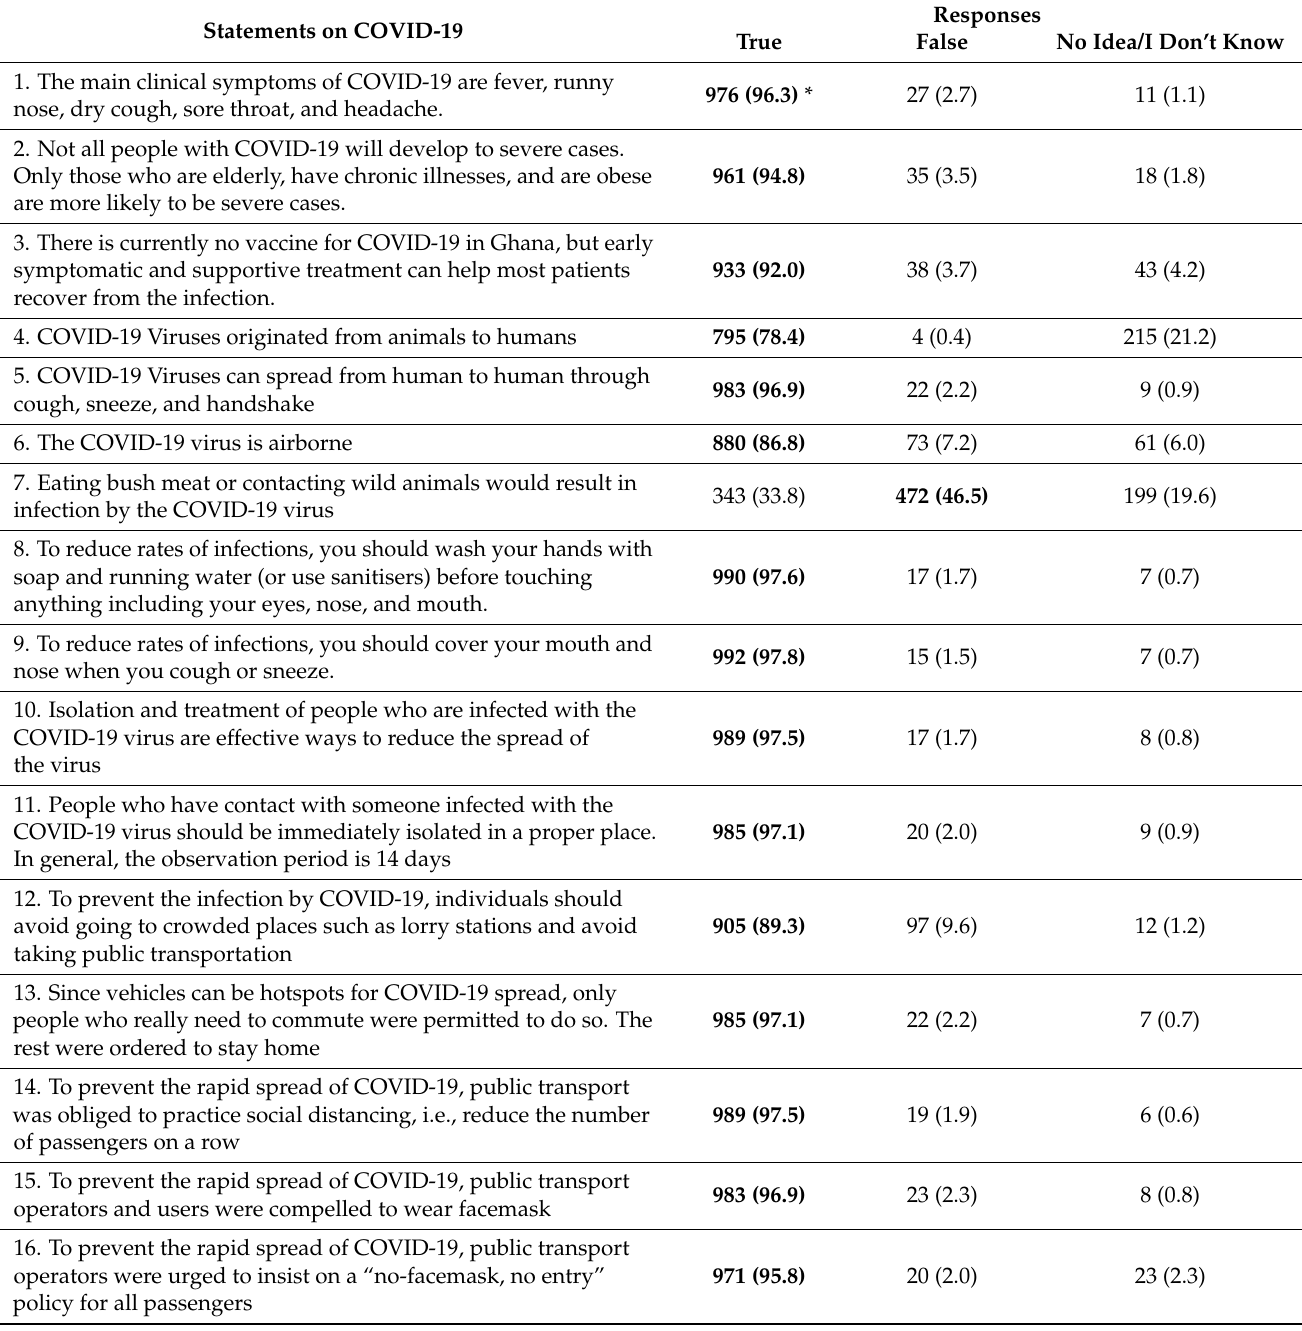
Table 3. Knowledge of COVID-19 among ride-hailing